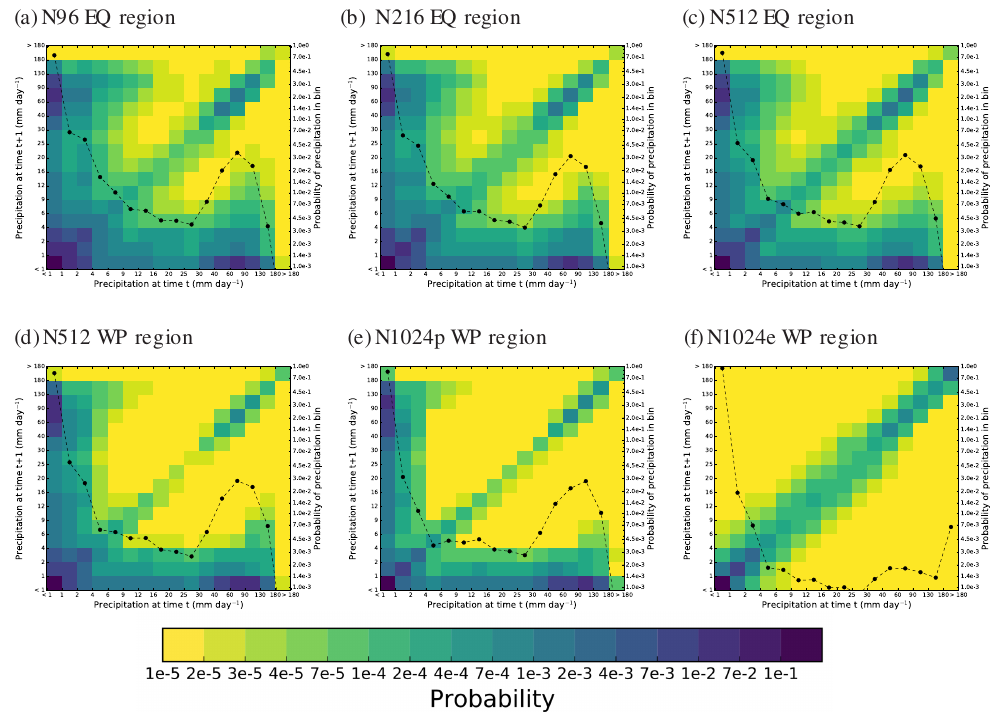
Figure 2. For each MetUM GA6 configuration in Table 1, the filled blocks show the 2-D histogram of binned rain rates (in mmday − 1 ) on consecutive time steps at the same grid box, aggregated over all grid boxes; the dashed line shows the 1-D histogram of binned precip- itation, using the right-hand vertical axis. Bins were chosen qualitatively such that 3-hourly TRMM analyses over the EQ region have an approximately uniform distribution for rain rates greater than 1mmday − 1 . Note the logarithmic colour